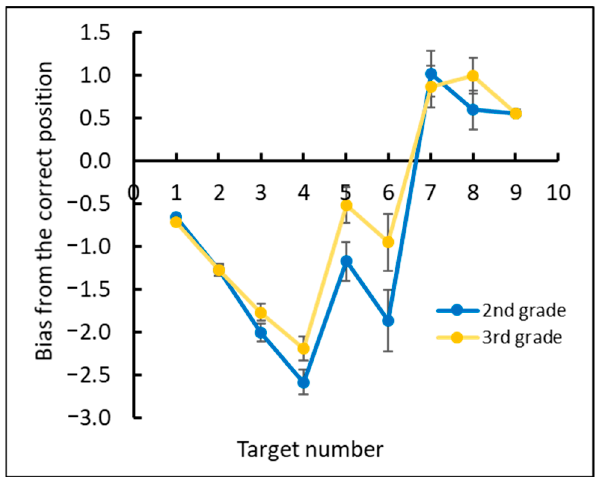
Figure 8. The mean bias value: the deviation between the estimated position of each target number and its correct position for each grade.